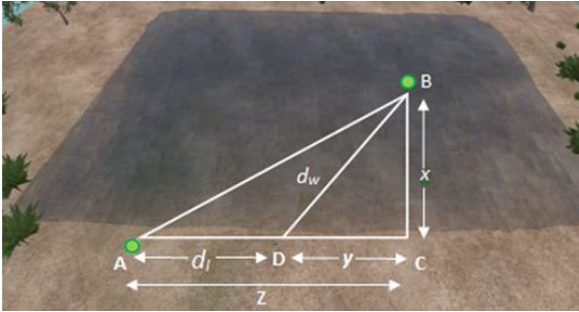
Figure 3. Possible paths: from location A on Land to location B in